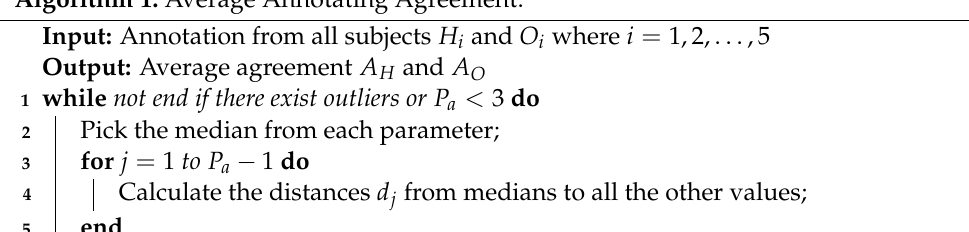
Algorithm 1: Average Annotating Agreement.